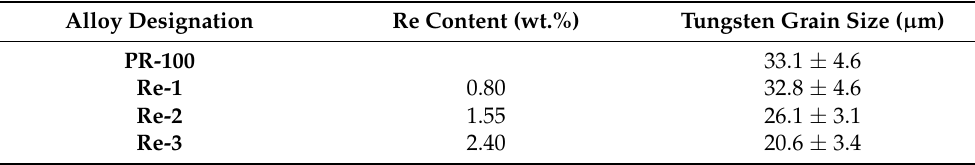
Table 5. The average tungsten grain